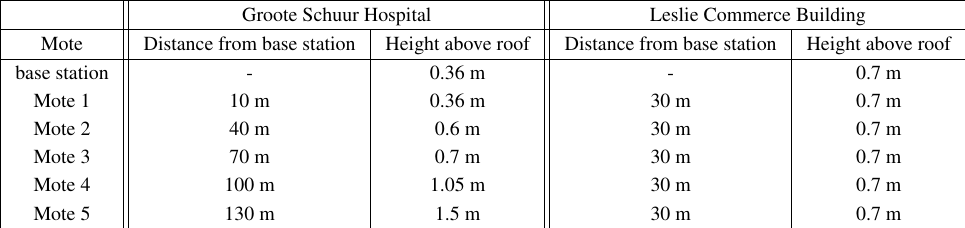
Table 3. Experimental